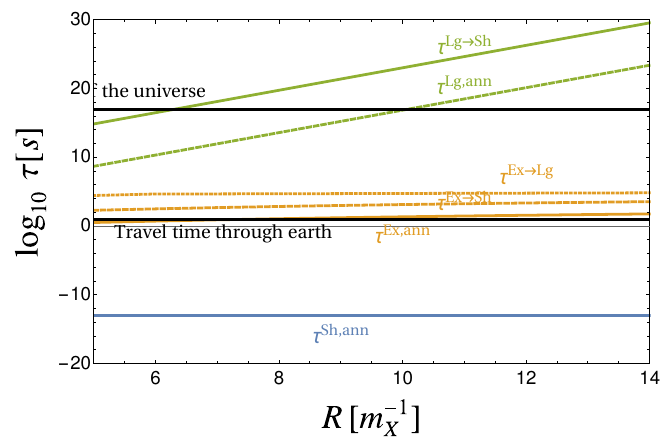
Figure 7 . Lifetimes for states in the two minima potential as function of the barrier width, for m (cid:31) = 0 : 5GeV ; (cid:11) V = 10 (cid:0) 2 .